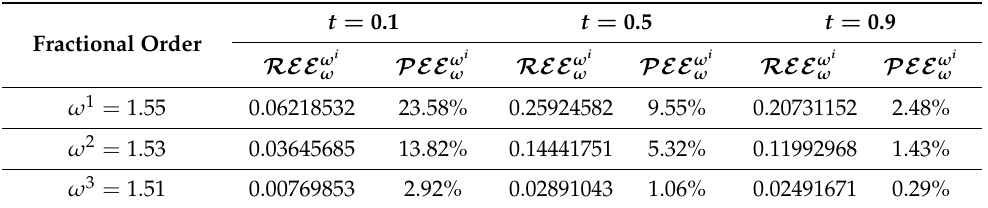
Table 2. The relative error and percent error estimations for ω = 1.5.